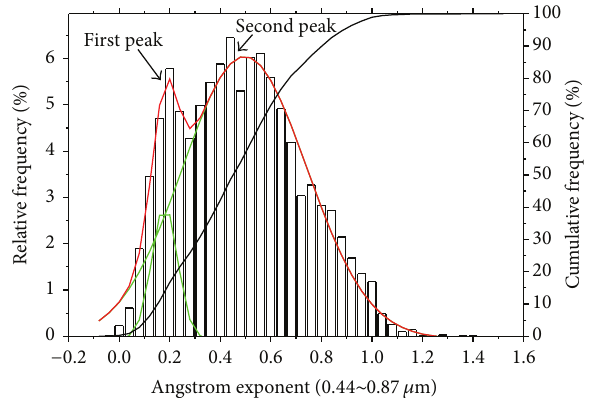
Figure 5: The monthly variation of ˚Angstr¨om exponent (0.44– 0.87 𝜇 m). Theleft axis corresponding to ˚Angstr¨omexponent and the right axis corresponding to number of